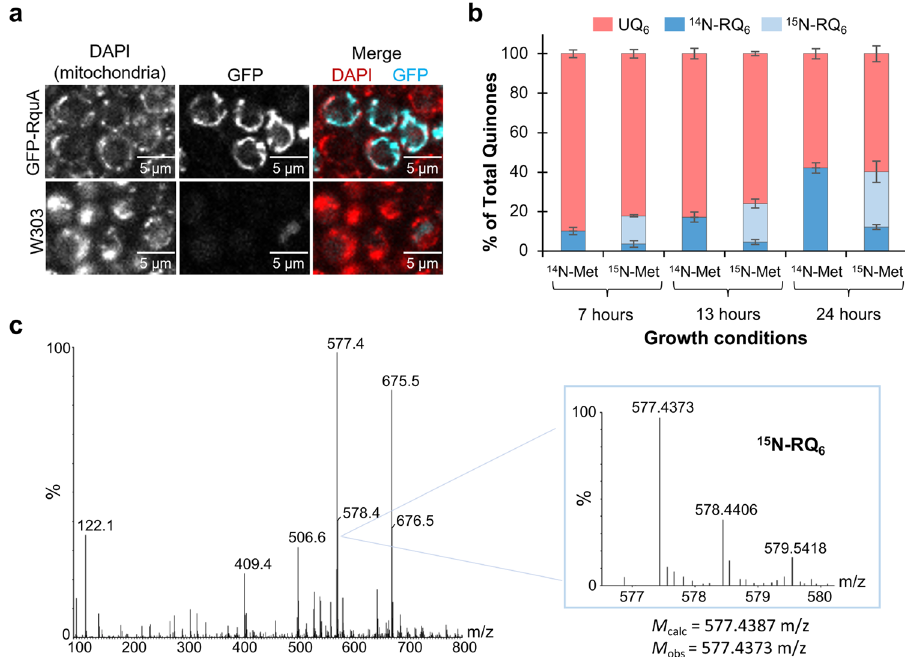
Fig. 3 Expression of GFP-RquA in S. cerevisiae . a Confocal microscopy images of yeast expressing GFP-RquA were imaged at 405 nm (DAPI: red) and 510 nm (GFP: cyan). The merged image (top right) shows an overlap of the GFP with the DAPI, indicating the localization of RquA in the mitochondria. b Yeast harboring pRCM_GFPRquA produce rhodoquinone-6 (RQ 6 , dark blue), and supplementation with 15 N- L -methionine yields 15 N-RQ 6 (light blue), The production of ubiquinone-6 (UQ 6 ) is shown in red. n = 2 biologically independent samples and error bars represent the standard deviation of the mean. c The experimental mass of synthesized [ 15 N-RQ 6 + H] + was determined to be 577.4373 m/z (C 38 H 58 15 NO 3 exact mass = 577.4387 m/z , mass accuracy = − 2.4